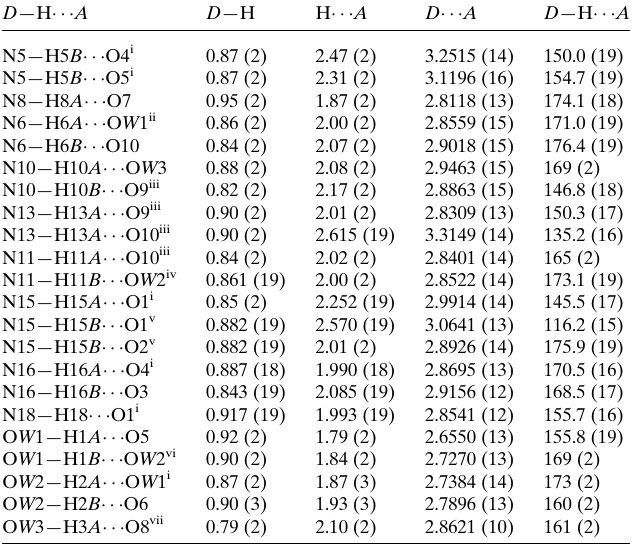
molecules (Fig. 1). The anionic complex has an overall charge of (cid:3) 3, requiring a vanadium atom with an oxidation state +5.